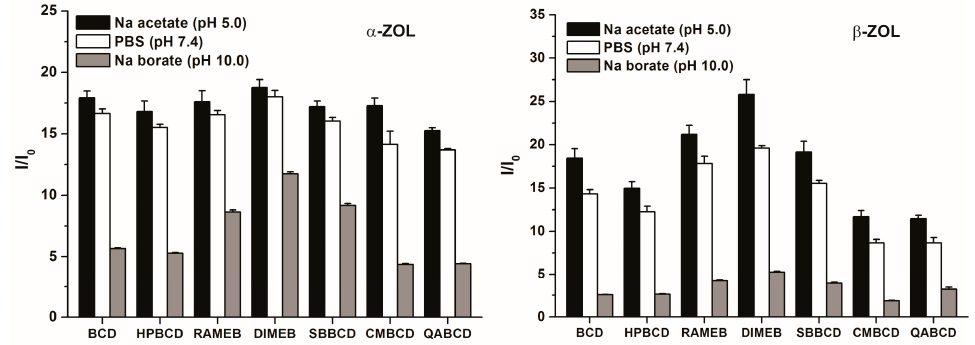
Figure 4. Fluorescence enhancement ( I / I 0 ) of α -ZOL (2 μ M; left ) and β -ZOL (2 μ M; right ) in the presence of 2 mM CD concentration in 0.05 M sodium acetate (pH 5.0), PBS (pH 7.4), and 0.05 M sodium borate (pH 10.0) buffers ( λ exc = 315 nm, λ em = 455 nm).